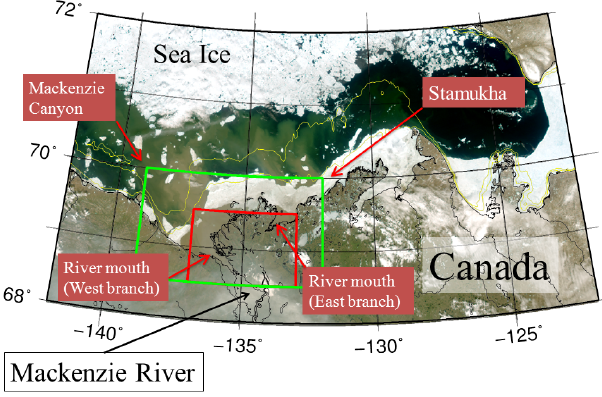
Figure 2. Quasi-true-color MODIS-Aqua image recorded on 24 June 2004 (250m spatial resolution). The study area includes the (i) Mackenzie River mouth west and east branches (red box) and delta zone (green box) and (ii) the Beaufort Sea in the Cana- dian Arctic Ocean. During winter time the connection between the river delta and adjacent coastal waters is closed by the stamukha while drifting sea ice develops